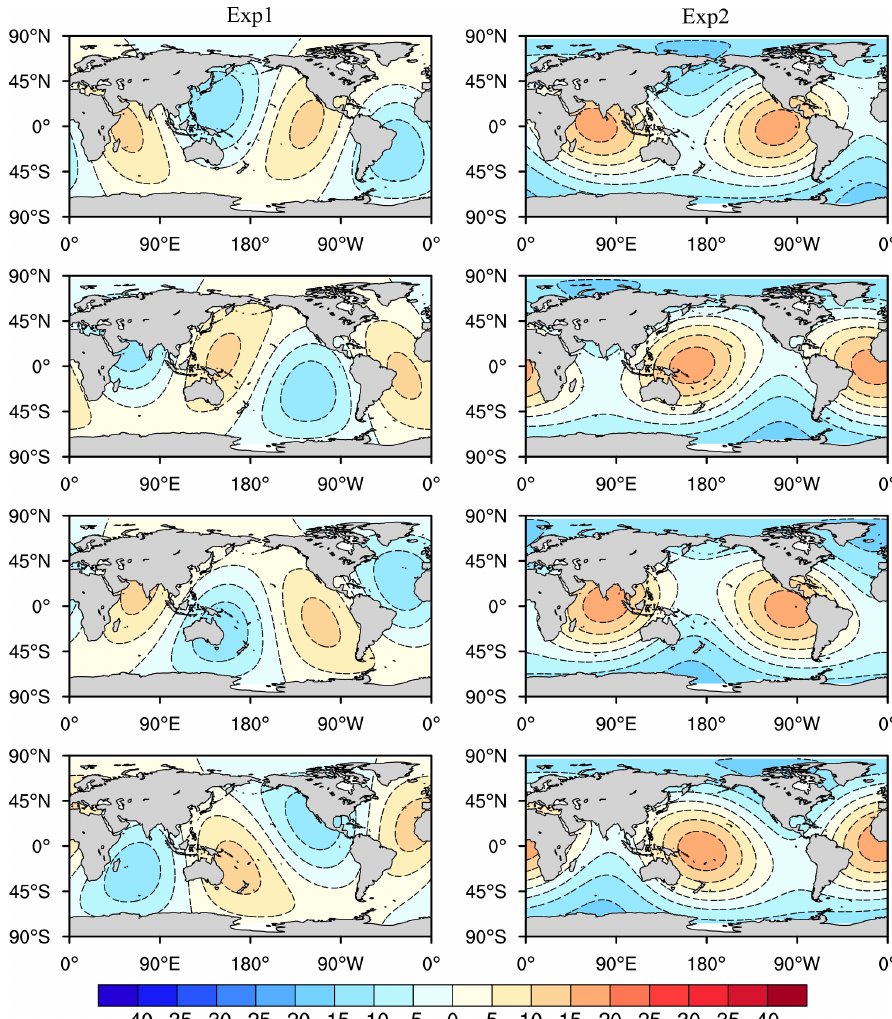
Figure 3. Spatial patterns of the neap tides for Exp1 (first column) and Exp2 (second column); the interval between the rows is 6h. The units are